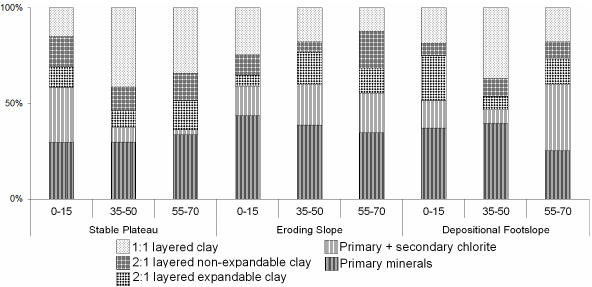
Figure 4. Composition of the mineral phase and quantification of primary vs. secondary minerals for the different slope positions and soil depths of the clay sized fraction (no distinction between pri- mary and secondary chlorite).